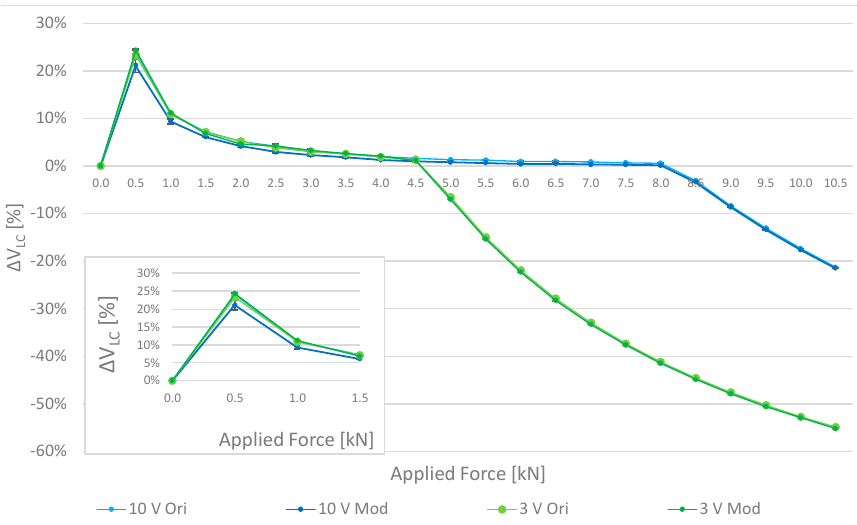
Figure 7. Load cell measured voltage by different applied forces and supplies. “ Ori ” is the LC sensor in a bare configuration, “ Mod ” is the cased one. “ 10 V ” and “ 3 V ” represent the different sensor supplies.